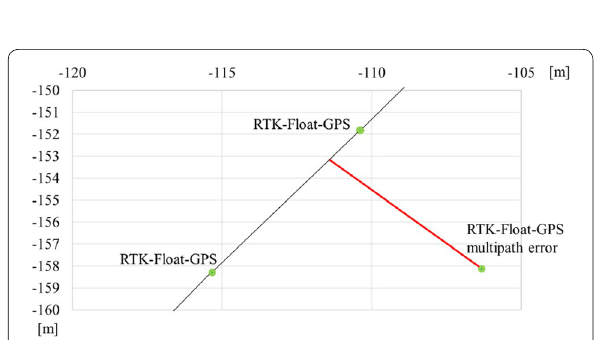
Fig. 17 Multipath error enlarged from Fig. 16. RTK-Float-GPS data (green), estimated RTK-Float-GPS trajectory (black line), and RTK- Float-GPS measurement error of 7.26 m caused by the multipath error (red line)